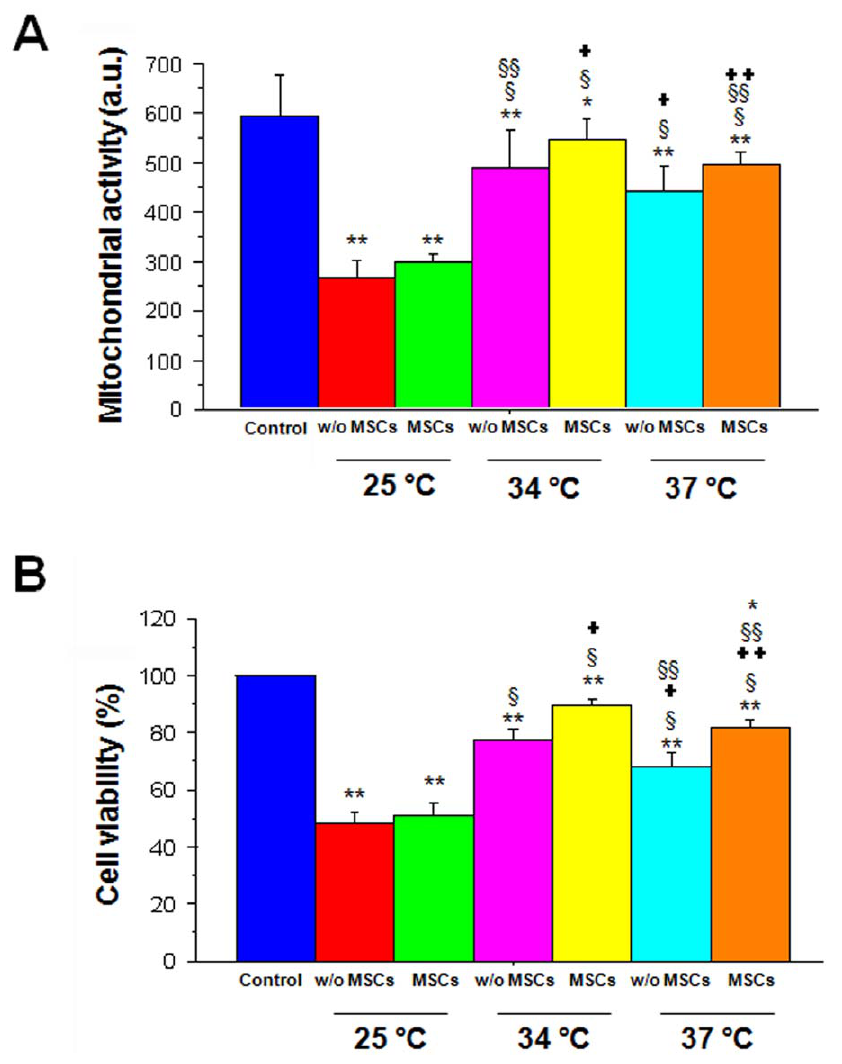
Figure 2. Measurement of cell viability and mitochondrial activity in PRNCs. Moderate hypothermia treatment indicated significant increase cell viability compared to normothermic and sever hypothermia treatments, and enhanced stem cells’ neuroprotection. Black- and white- columns indicate non-implementation and MSCs implementation after 2 hours reperfusion, respectively. Control shows a normoxic condition, atmosphere at 37 u C, 95% O 2 , and 5% CO 2 . + Under same temperature condition, P value of comparison non-MSCs with MSCs implementation is less than 0.05. * P , 0.05: ** P , 0.01: *** P , 0.005. Similarly, moderate hypothermia treatment indicated significant increase in mitochondrial activity compared to normothermic and severe hypothermia treatments, and enhanced stem cells’ neuroprotection. Black- and white-columns indicate non- implementation and MSCs implementation after 2 hours reperfusion, respectively. Cont shows a normoxic condition, atmosphere at 37 u C, 95% O 2 , and 5% CO 2 . + Under same temperature condition, P value of comparison non-MSCs with MSCs implementation is less than 0.05. * P , 0.05: ** P , 0.01: *** P , 0.005. a.u.=absorbance unit.